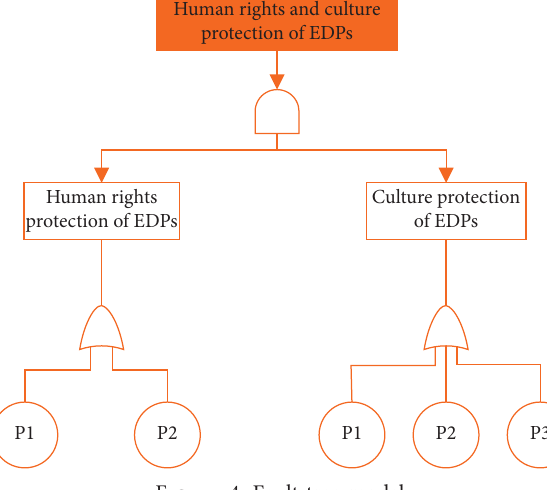
Figure 4: Fault tree